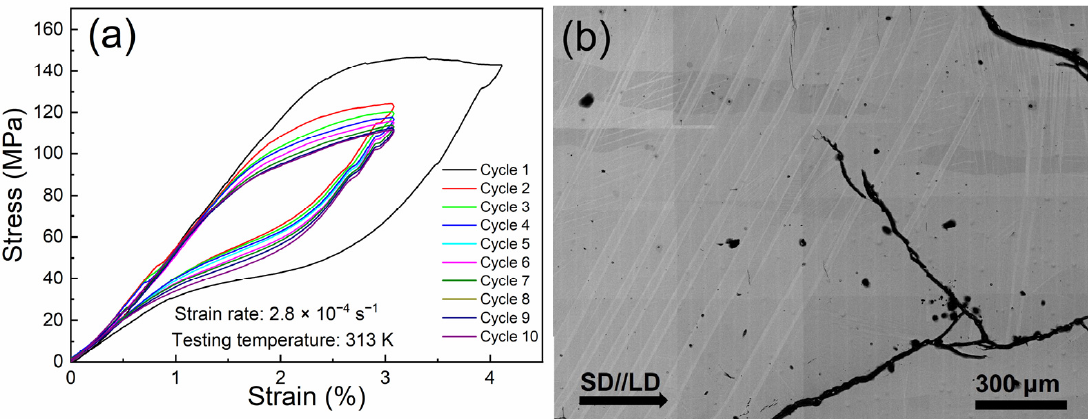
Figure 5. ( a ) Cyclic compressive stress–strain curves of superelastic training for the directionally solidified Ni 44.5 Co 4.9 Mn 37.5 In 13.1 alloy at 313K with the loading direction (LD) along the SD. ( b ) Mi- crostructure for the alloy after superelastic training at room temperature.